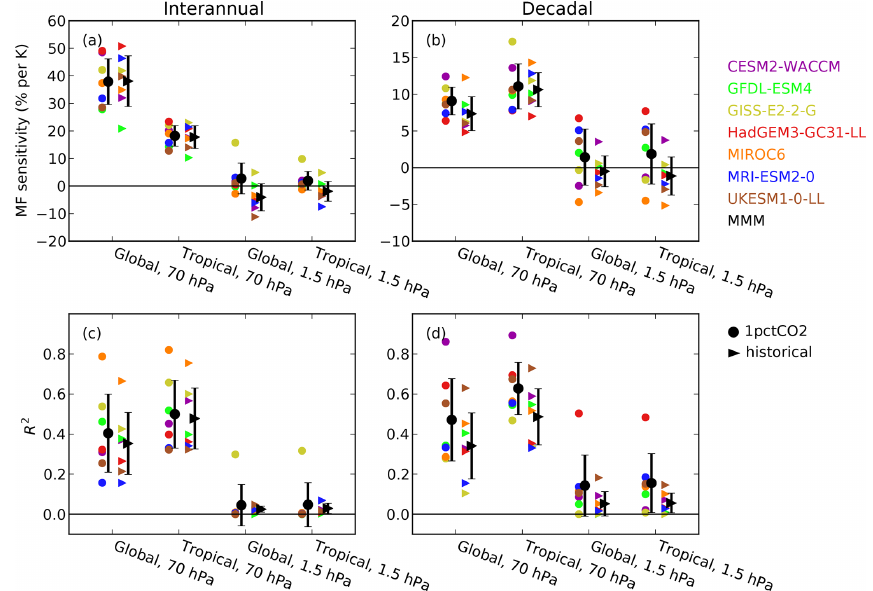
Figure 14. Regression (a, b) and determination (c, d) coefficients between mass flux in the upper and lower stratosphere with global and tropical mean surface temperature on interannual (a, c) and decadal (b, d) timescales. Interannual variability is obtained as the annual mean minus 5-year running mean data; decadal variability is the detrended 5-year mean. Black error bars show the MMM and 1 standard deviation among models. Triangles denote output from historical runs and circles from 1pctCO2